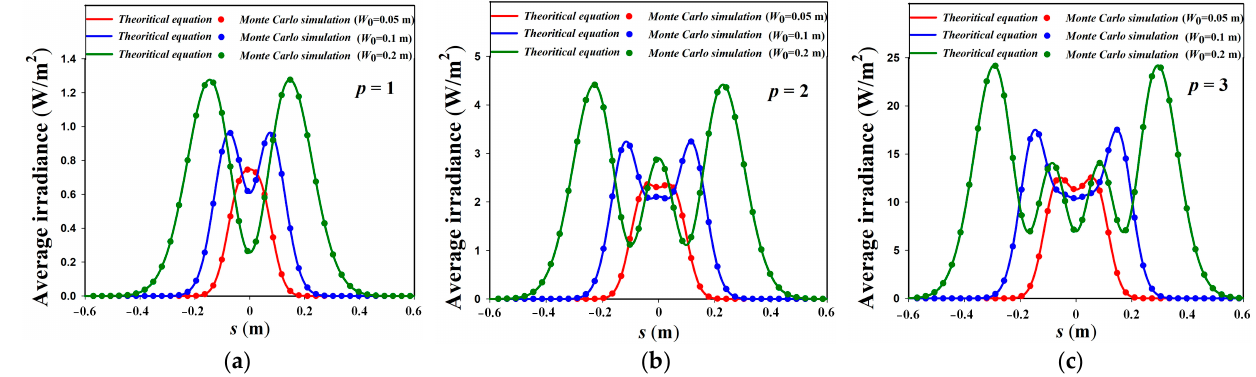
Figure 5. Average irradiance of HG beam under pointing error with different beam waists at trans- mitter. ( a ) p = 1, ( b ) p = 2 and ( c ) p = 3. transmitter. ( a ) p = 1, ( b ) p = 2 and ( c ) p =